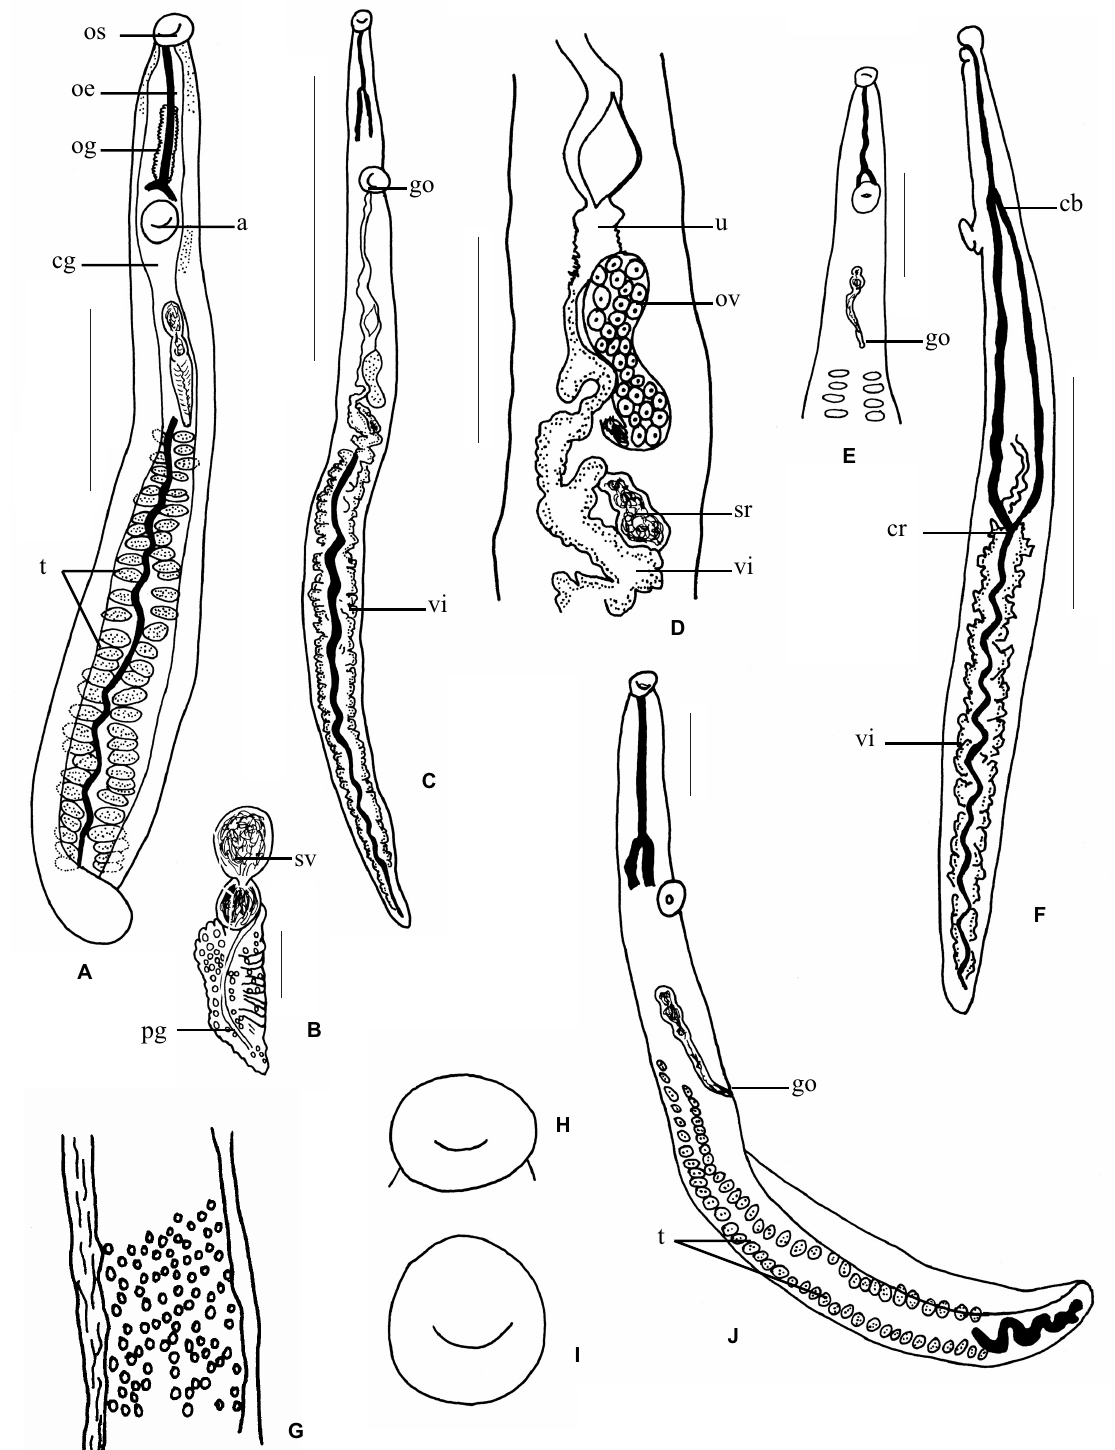
Fig. 1. – Bilharziella polonica autumn morph (A-D, G-I: Anas platyrhynchos ; E, F: Ardea cinerea ; J: C. olor ) (male: A, B, E, G, J; female: C, D, F, H,